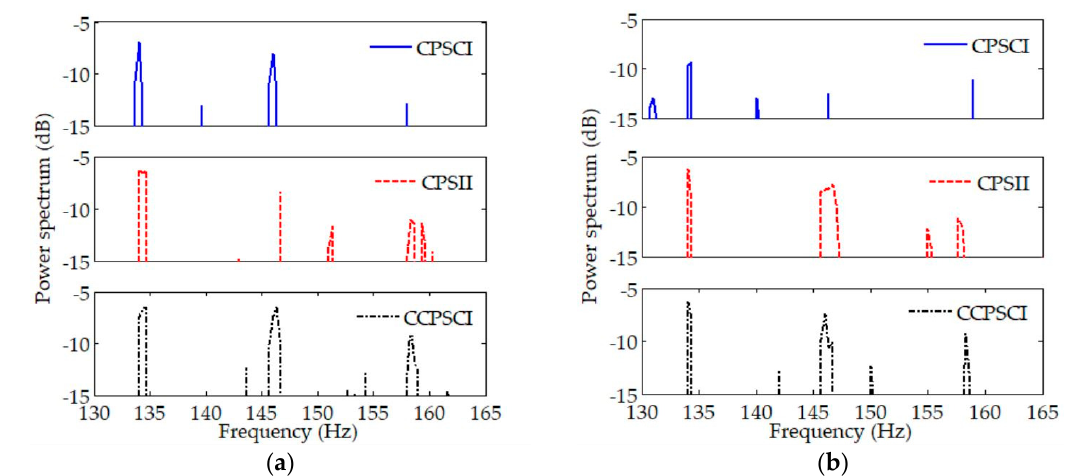
Figure 8. Averages of power spectra estimated by CPSCI, CPSII, and CCPSCI with ( a ) SNR = 20 dB and ( b ) SNR = − 10 dB during the time period of ~20–50 s in simulation. Compared with CPSII and CCPSCI, the performance of CPSCI for signal enhancement is unsatisfactory and gets worse under low SNR. As shown in ( a , b ), CCPSCI can provide an extra integration gain of ~2–4 dB.